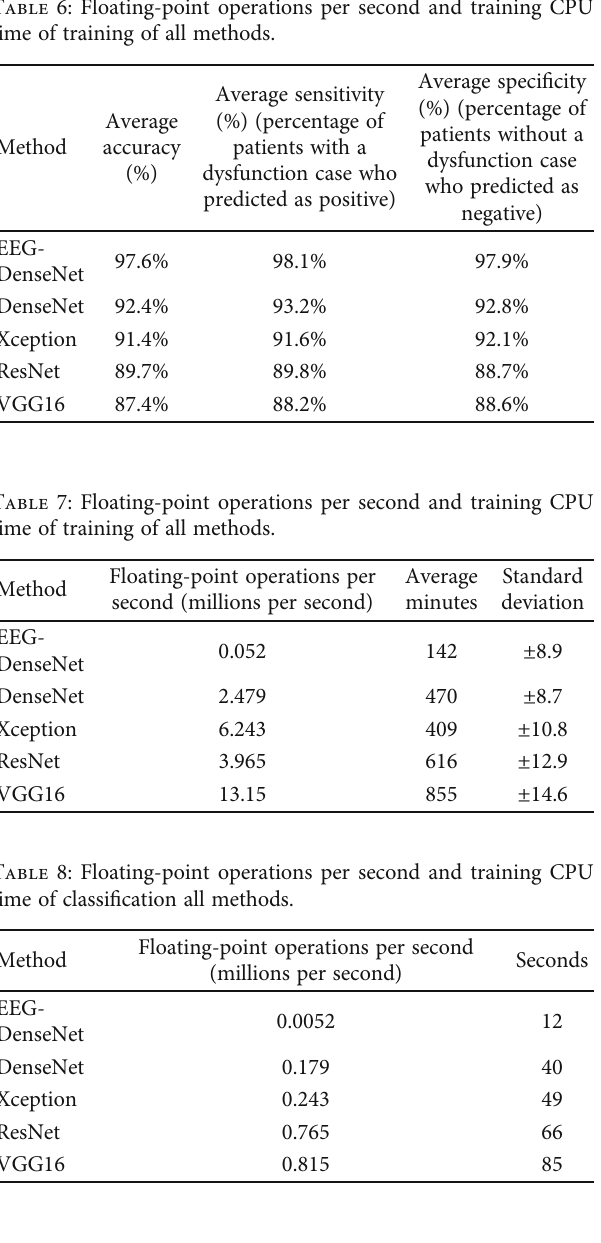
Table 9: Statistics for using EEG-DenseNet model with and without fi ne